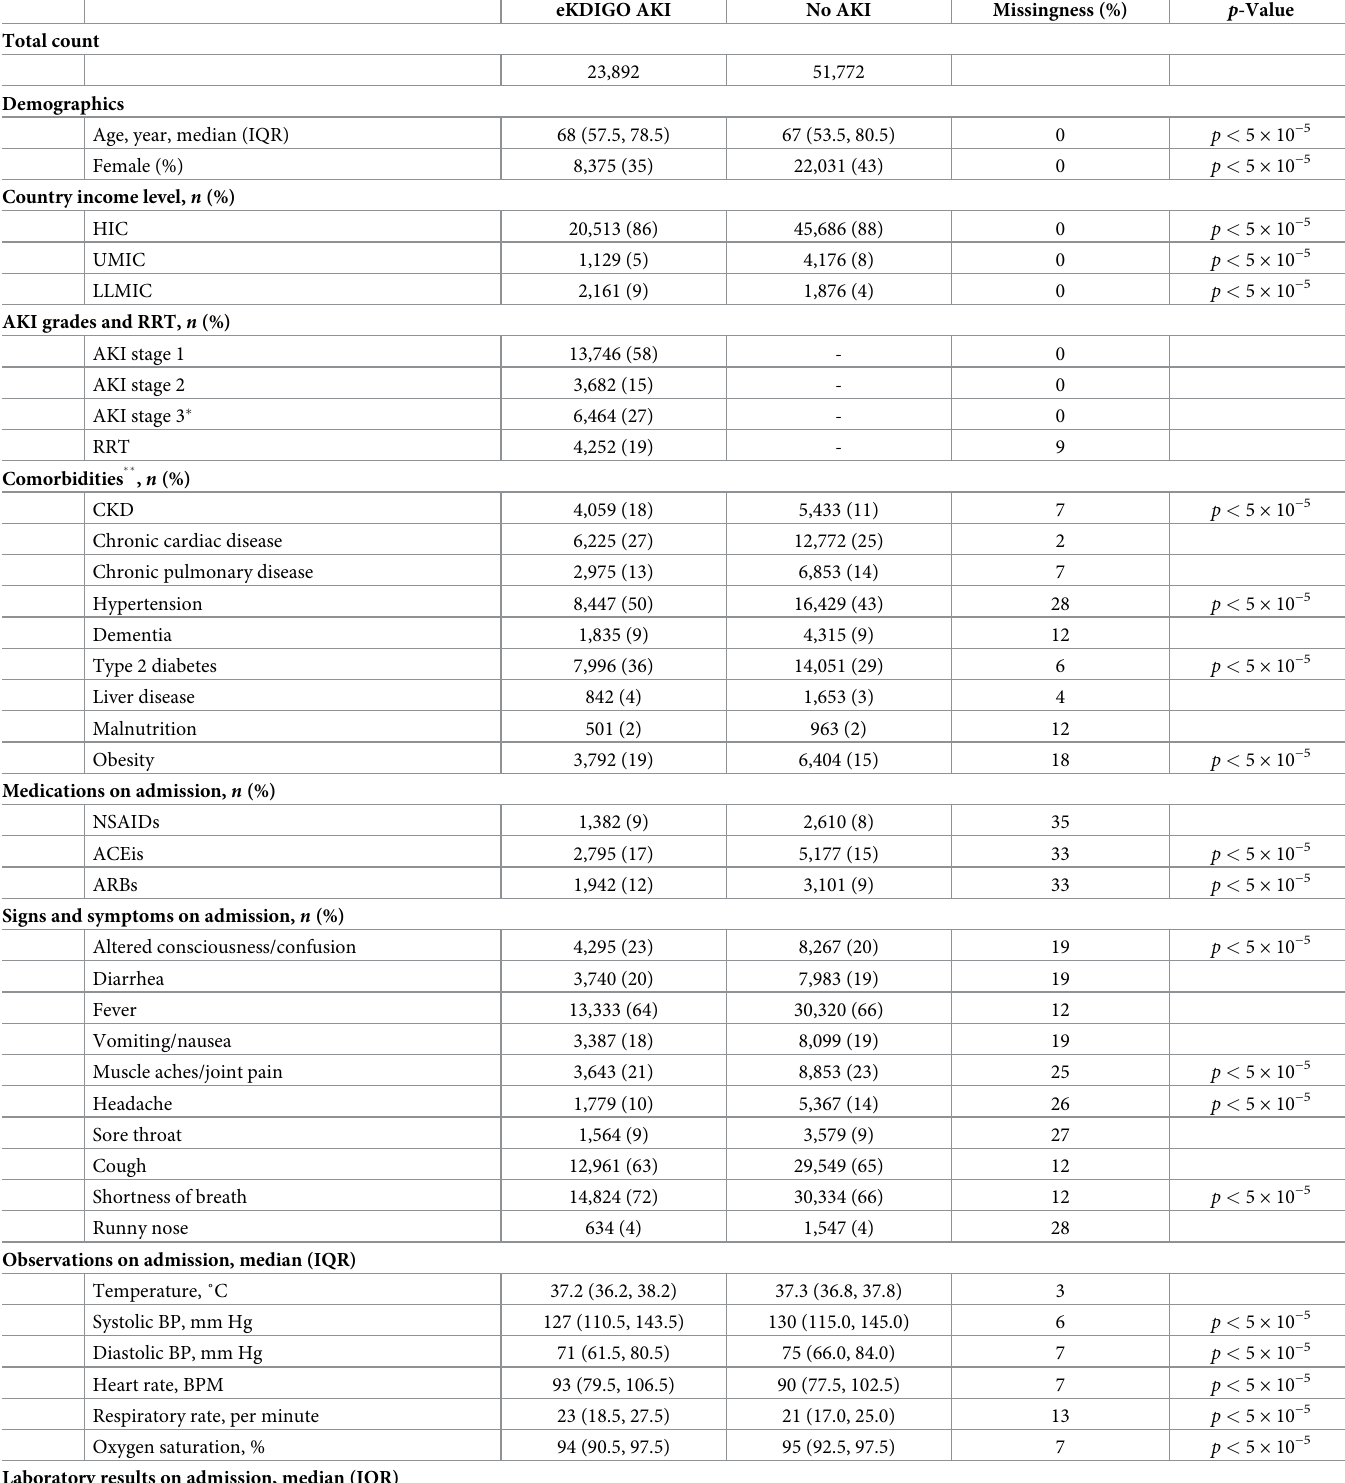
Table 2. Characteristics of patients with no AKI and AKI diagnosed by eKDIGO